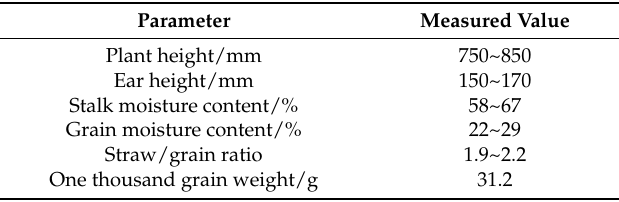
Table 2. Basic characteristics of the rice used in the test.